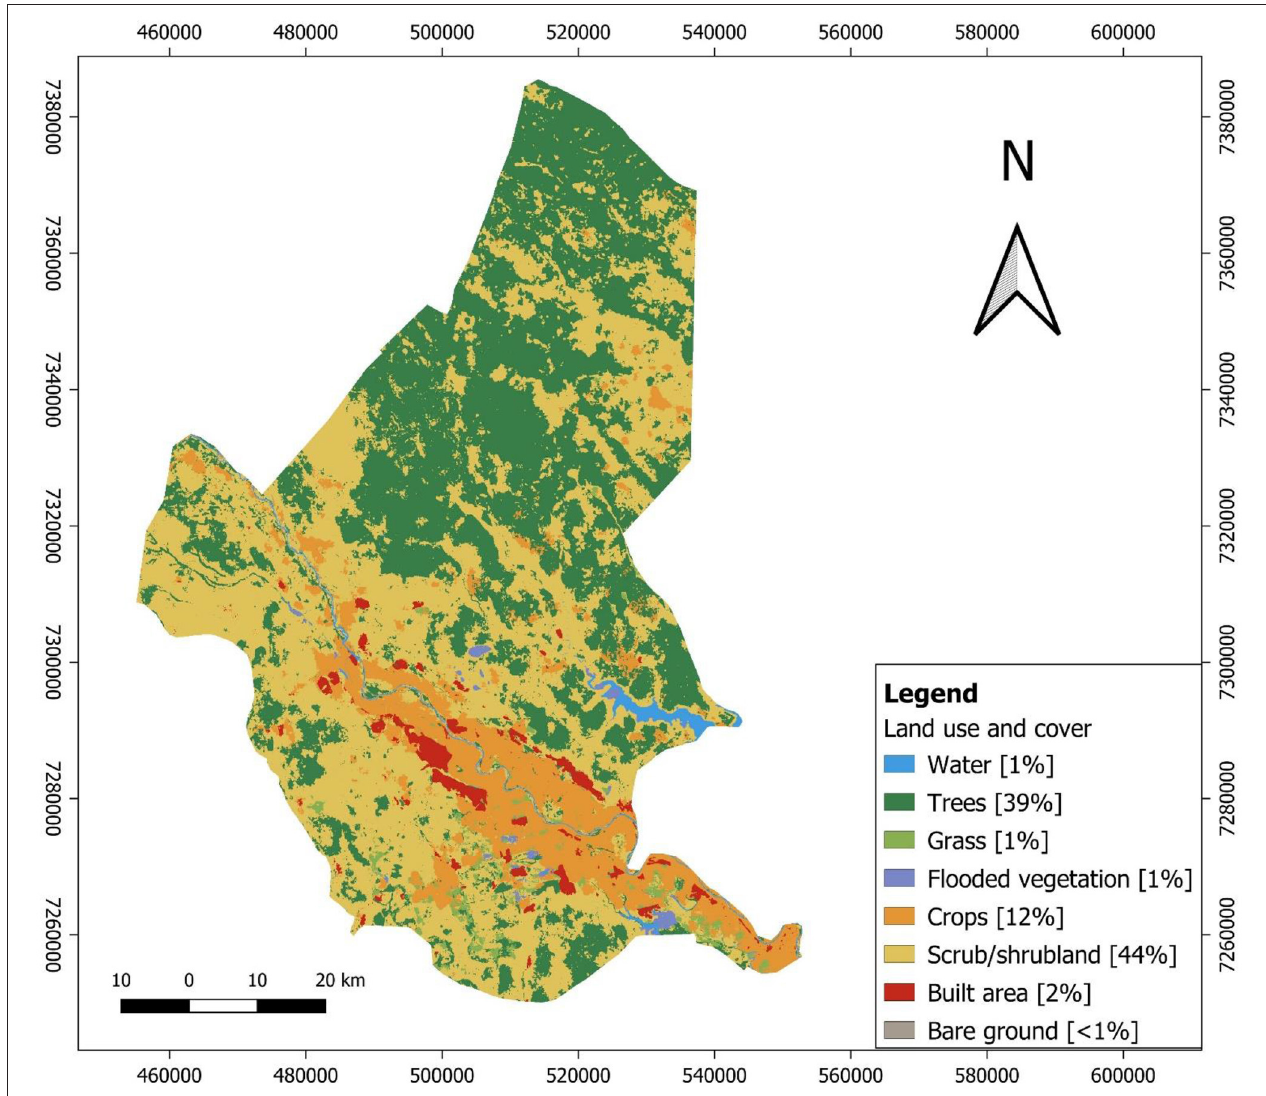
FIGURE 3 | Description of land cover and use with the respective class definitions. The map is derived from ESA Sentinel-2 satellite imagery at 10m resolution published on July 2021. It is composed of land use and land cover predictions for 10 classes throughout the year, representing the snapshots of